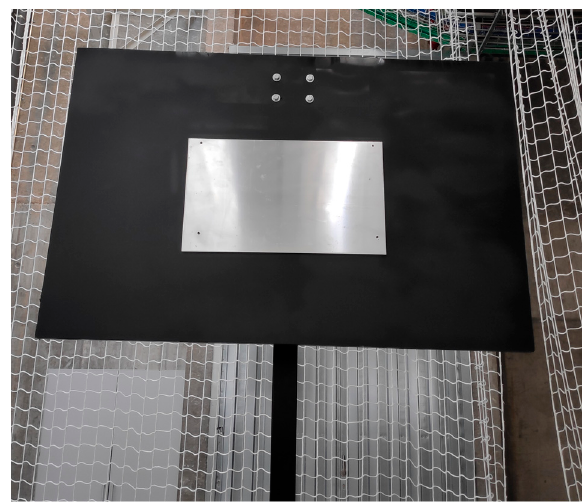
Figure 12. Structure used for the tests.